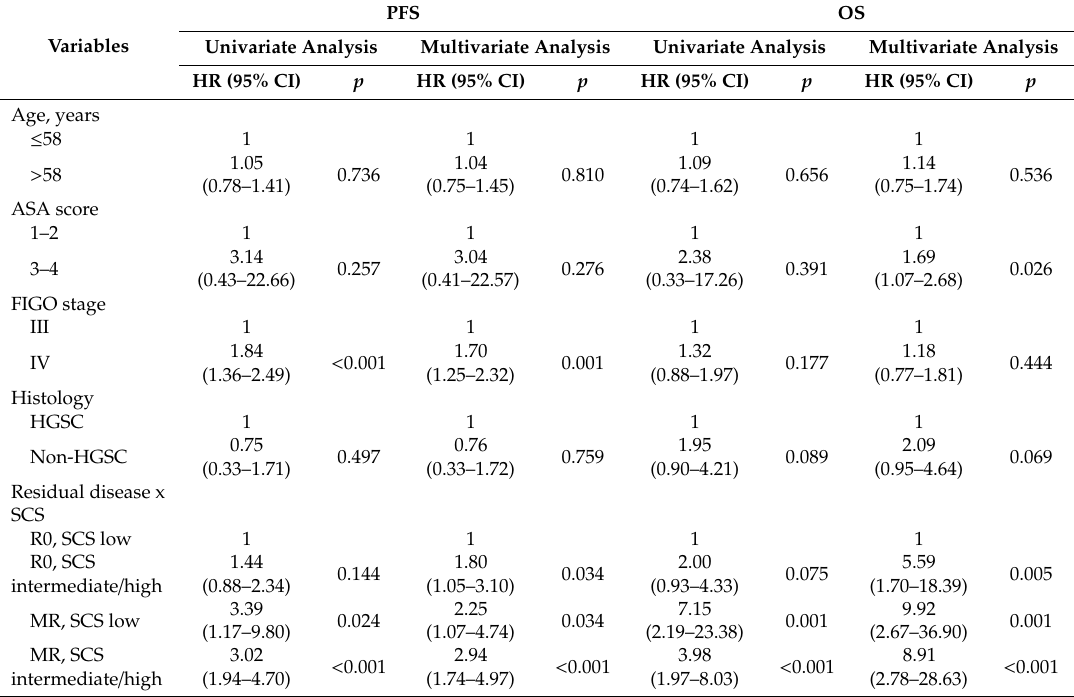
Table 2. Univariate and multivariate analyses for progression-free and overall survival using a Cox proportional hazards